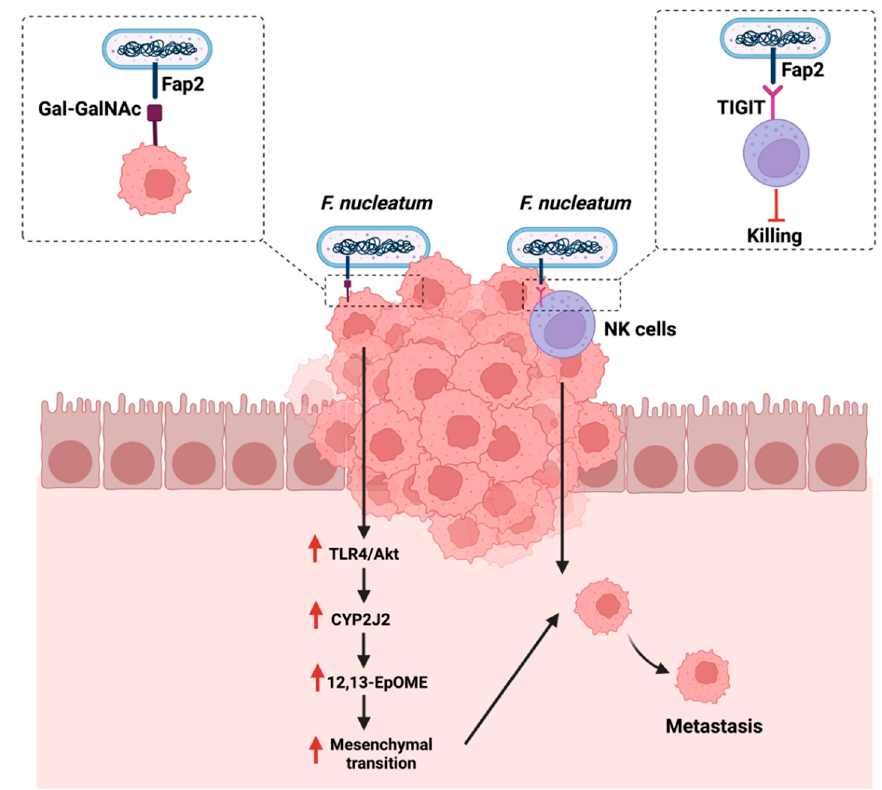
Figure 5. Summarizes the influence of Fusobacterium nucleatum on cancer metastasis either by targeting sugar residues Gal-GalNAc on cancerous cells or targeting receptors that are overexpressed on natural killer cells (NK). “Created with BioRender.com”.